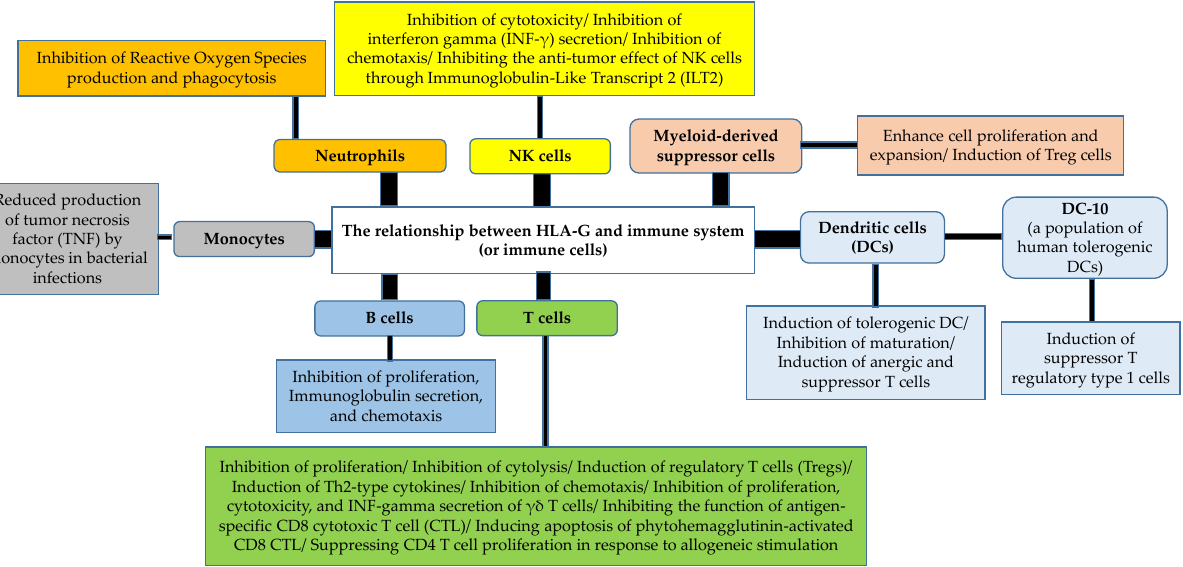
Figure 1. Various immune tolerogenic properties of HLA-G by modulating the functions of immune cells